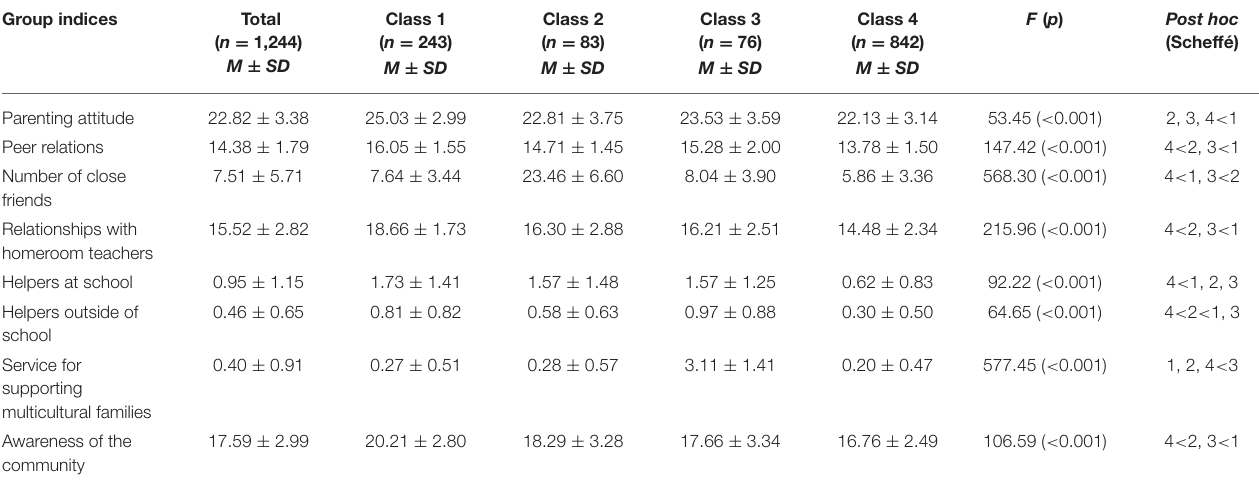
TABLE 2 | Differences in indices of social capital among latent classes ( N = 1,244). Group indices